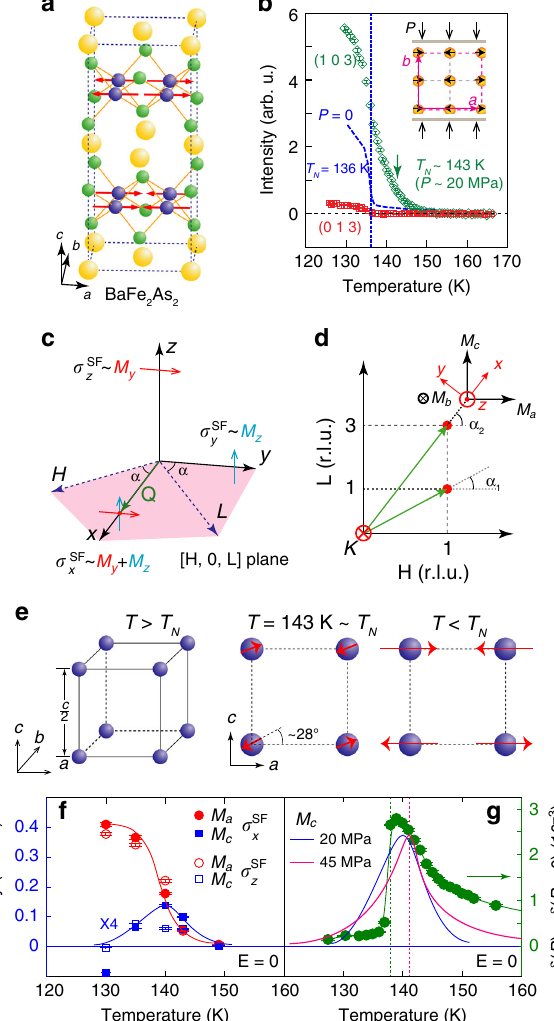
Fig. 1 Summary of the effect of uniaxial pressure on crystalline lattice and magnetic structures of Ba 2 Fe 2 As 2 . a Crystal and AF structure of BaFe 2 As 2 . The red arrows indicate the a -axis direction of magnetic moments. b Magnetic order parameters measured at Q 1 = (1, 0, 3) and Q = (0, 1, 3) under uniaxial pressure, revealing T N = 143 K. The blue dashed curve denotes the magnetic order parameter measured on a strain-free sample with T N = 136 K. c Scattering geometry of polarized neutron scattering experiment in the [ H , 0, L ] plane. d The reciprocal space, where the fl uctuating moments along the a -, b -, and c -axis directions are marked as M a , M b , and M c , respectively. e Spin arrangements of BaFe 2 As 2 in the paramagnetic (left), near T N (middle), and low-temperature AF state. f Temperature dependence of the static ordered magnetic moment M a and M σ SF c as determined from x ; z at (1, 0, 1) and (1, 0, 3). The vertical error bars are estimated errors from fi ts-to-order parameters. g Comparison of temperature dependence of the strain-induced lattice distortion from ref. 27 and our estimated M c at ~20 (blue solid line) and ~45 (pink solid line)